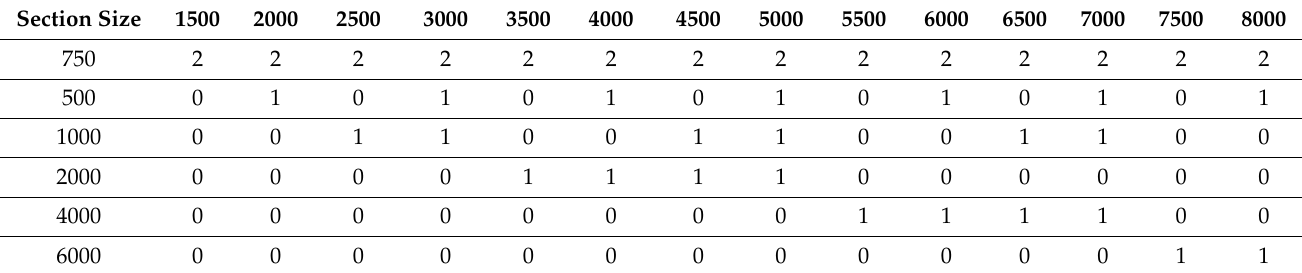
Table 1. Number of subassembly sections in relation to the total length of